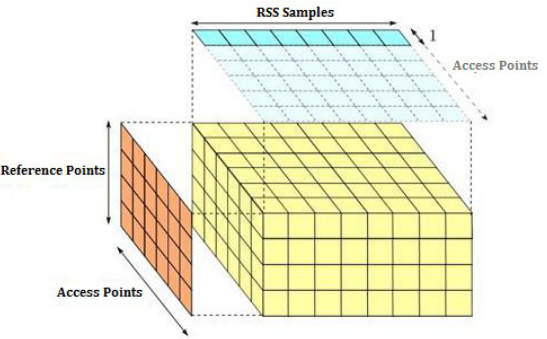
Figure 5. Radio map. Obtained collection of fingerprint matrix layout as a result of the data preparation step of real RSS XML data measurements.